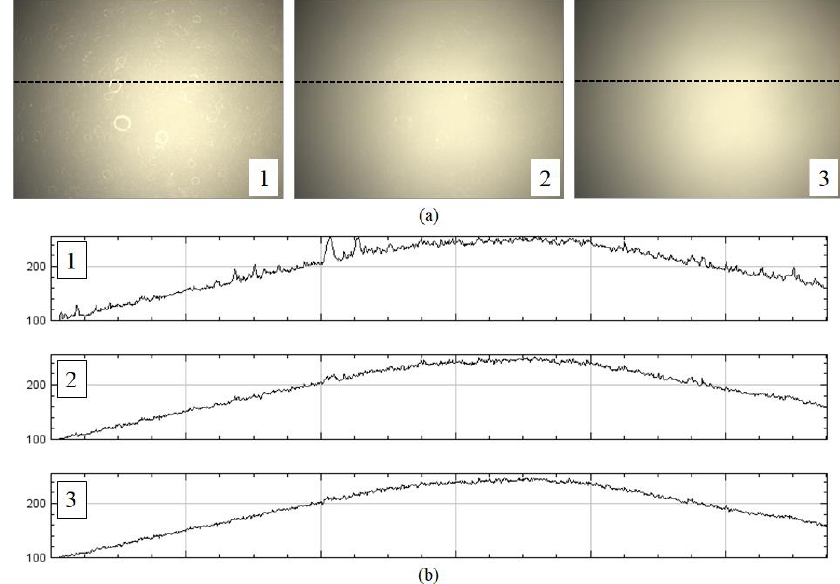
Figure 3. Example of artifacts reflected on candidates constructed with higher values: ( a ) enlarged images for 1, 2 and 3 of Figure 2 , and ( b ) intensity profiles for a red channel on a dotted line.